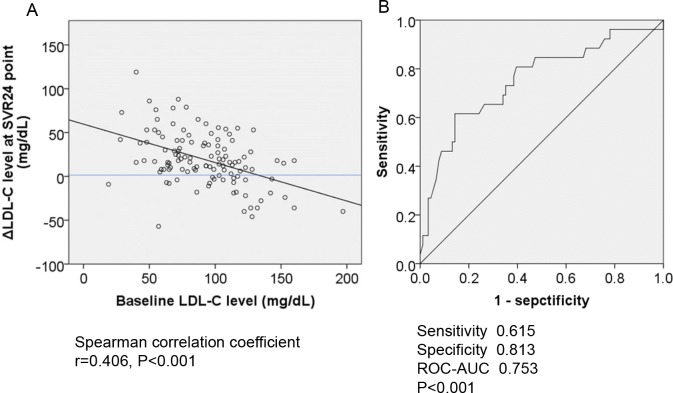
A-B. The correlation between baseline LDL-C and the change in LDL-C after successful HCV eradication by IFN-free DAAs. (3A) The baseline LDL-C level and ΔLDL-C level were significantly negatively correlated (r = 0.406, P <0.001). (3B) ROC curve analysis for ΔLDL-C level. The cut off baseline LDL-C associated with ΔLCL-C is 108 mg/dL (ROC-AUC = 0.615; P <0.001; sensitivity, 0.813; specificity, 0.753). LDL-C; low density lipoprotein-cholesterol, ΔLDL-C; the value at SVR24 minus the value at baseline, SVR; sustained viral response, DAAs, direct-acting antiviral agents.